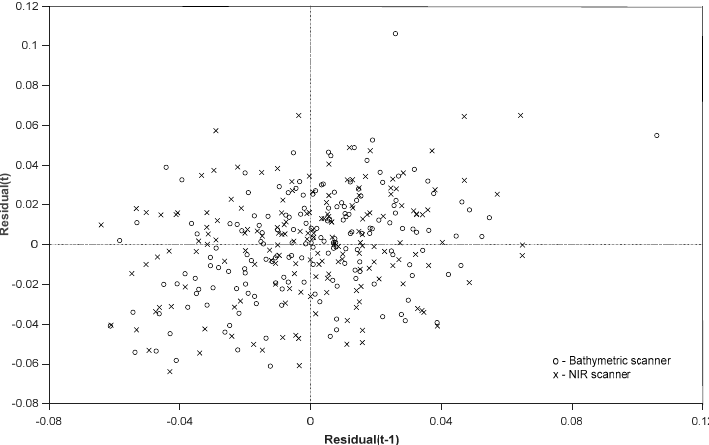
Figure 11. Slant-range adjustment of Chiroptera scanners; control points versus Lidar-derived patch elevation-lagged residuals. Residuals do not indicate any underlying patterns, but only a few outlier measurements.